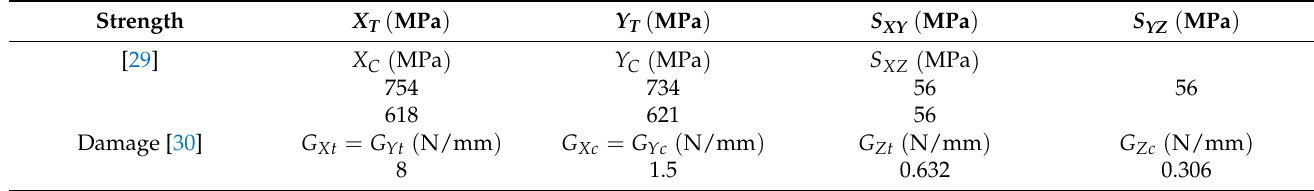
Table 3. Strength and damage data corresponding to the SiC f /SiC